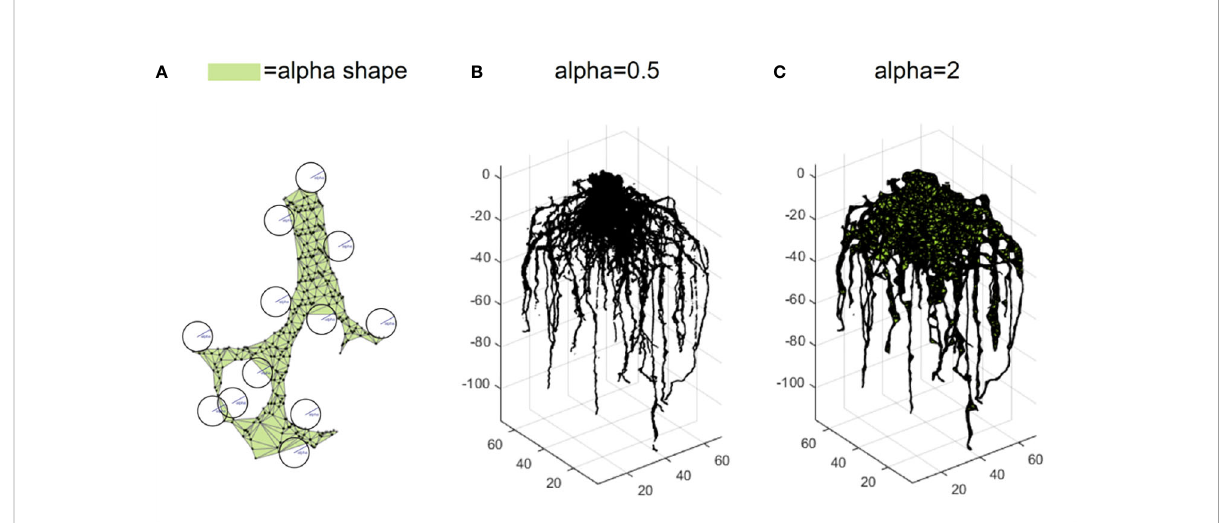
FIGURE 6 Trait extraction via alpha shape analysis. An alpha shape is a kind of shape that envelopes the point cloud (A) . Intuitively, it is formed by scooping out ice cream with a sphere spoon without bumping into chocolate pieces (the points) and then straightening the boundaries. The volumes of alpha shape can be calculated for different parameters such as alpha=0.5 (B) and alpha=2 (C)